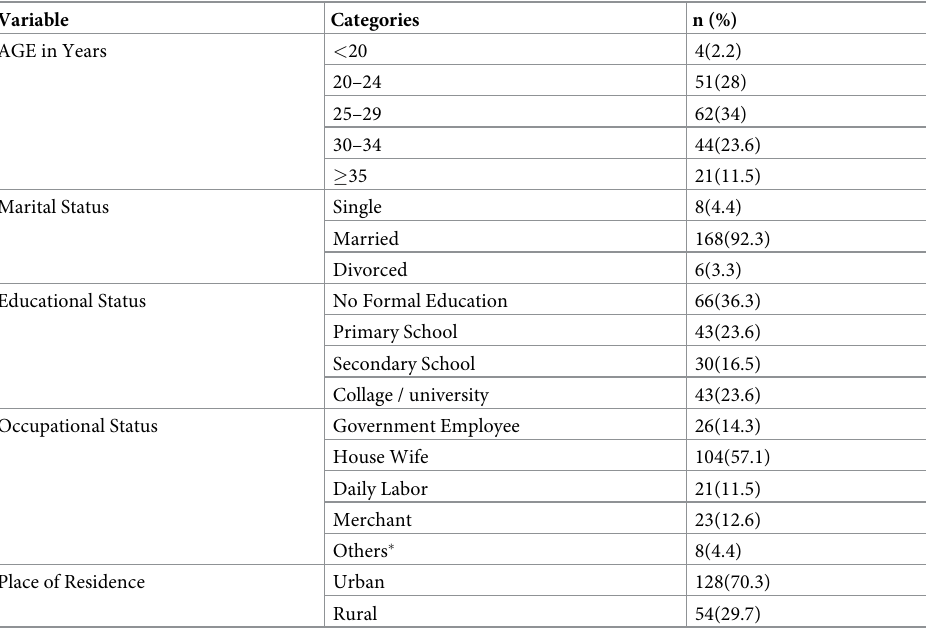
Table 1. Sociodemographic characteristics of respondents, in Bahir Dar City Public Hospitals, Ethiopia, 2020 (n = 182).